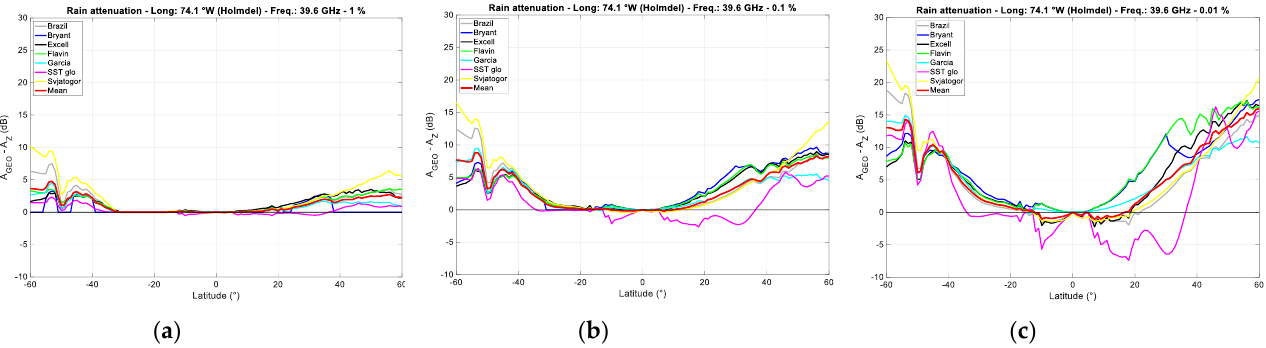
Figure 5. The difference A GEO − A Z , calculated at fixed annual probabilities 1% ( a ), 0.1% ( b ), and 0.01% ( c ), between the rain attenuation exceeded in the GEO path, A GEO , and the rain attenuation exceeded in the GeoSurf path, A Z , i.e., at the zenith in Holmdel; 39.6 GHz, circular polarization.